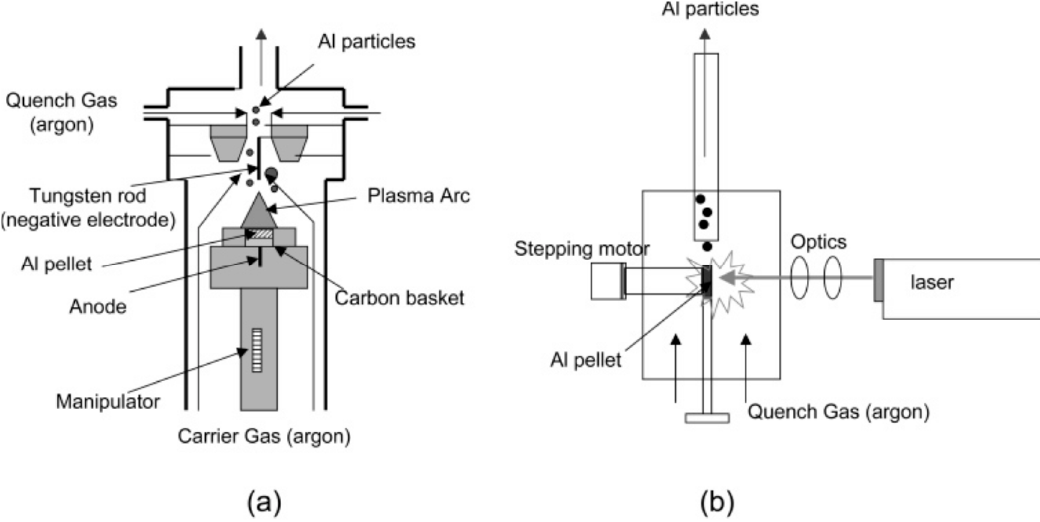
Figure 9. Methods used for generating nanoparticles of Al: ( a ) through DC arc discharge, ( b ) via laser ablation. Reprinted from [29] with permission from J. Phys. Chem. B. Copyright 2005 American Chemical Society.